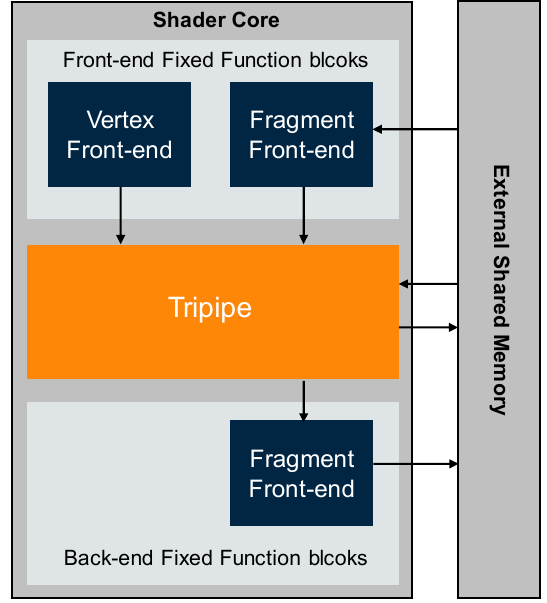
Figure 8. An abstract inside view of a shader core [16].